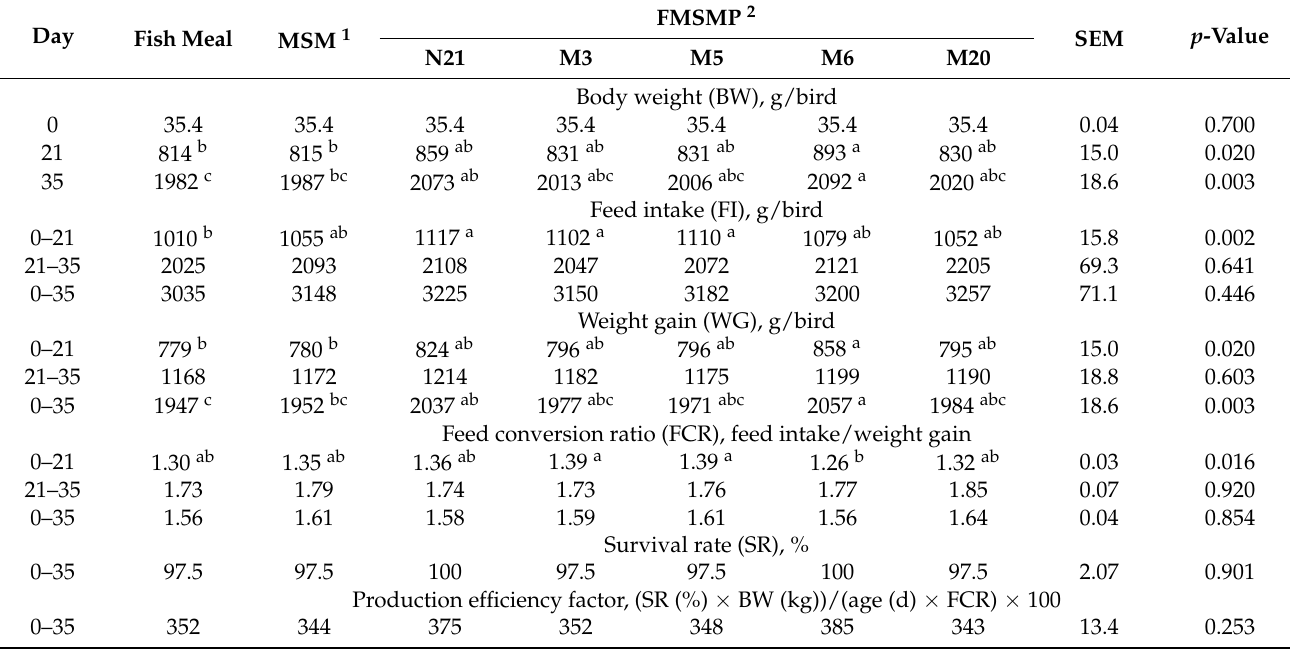
Table 7. The effect of different FMSMPs on broiler growth